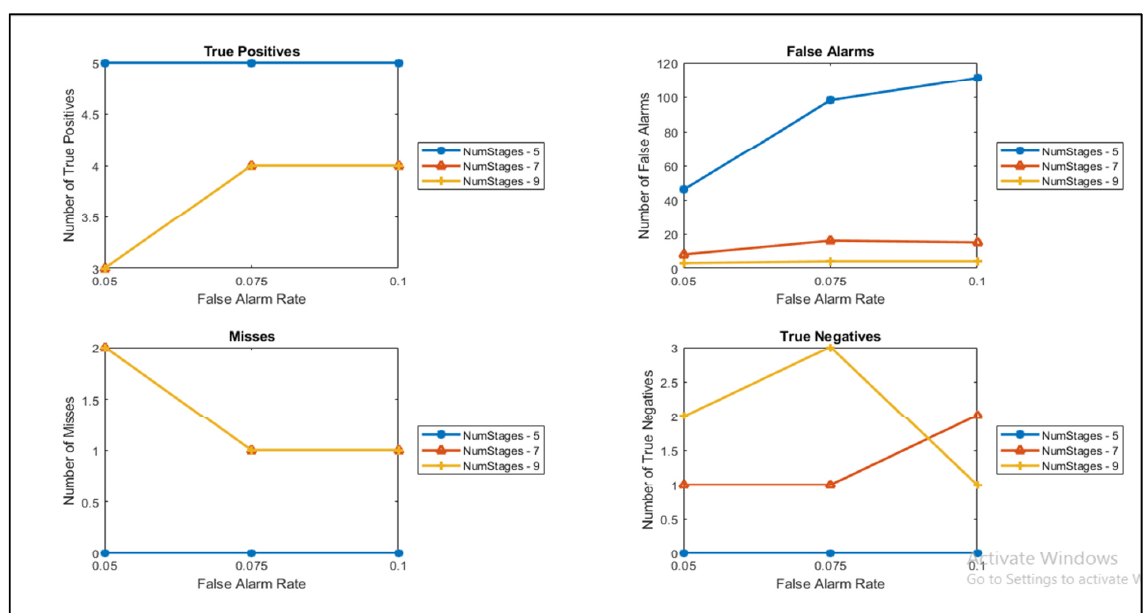
Fig. 10. Results with different values of the False Alarm